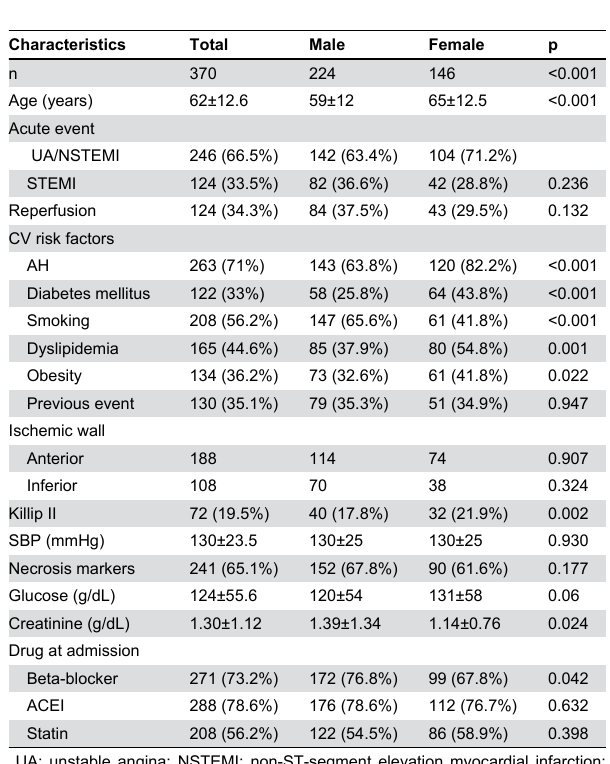
Table 1. Demographic and clinical variables of the studied